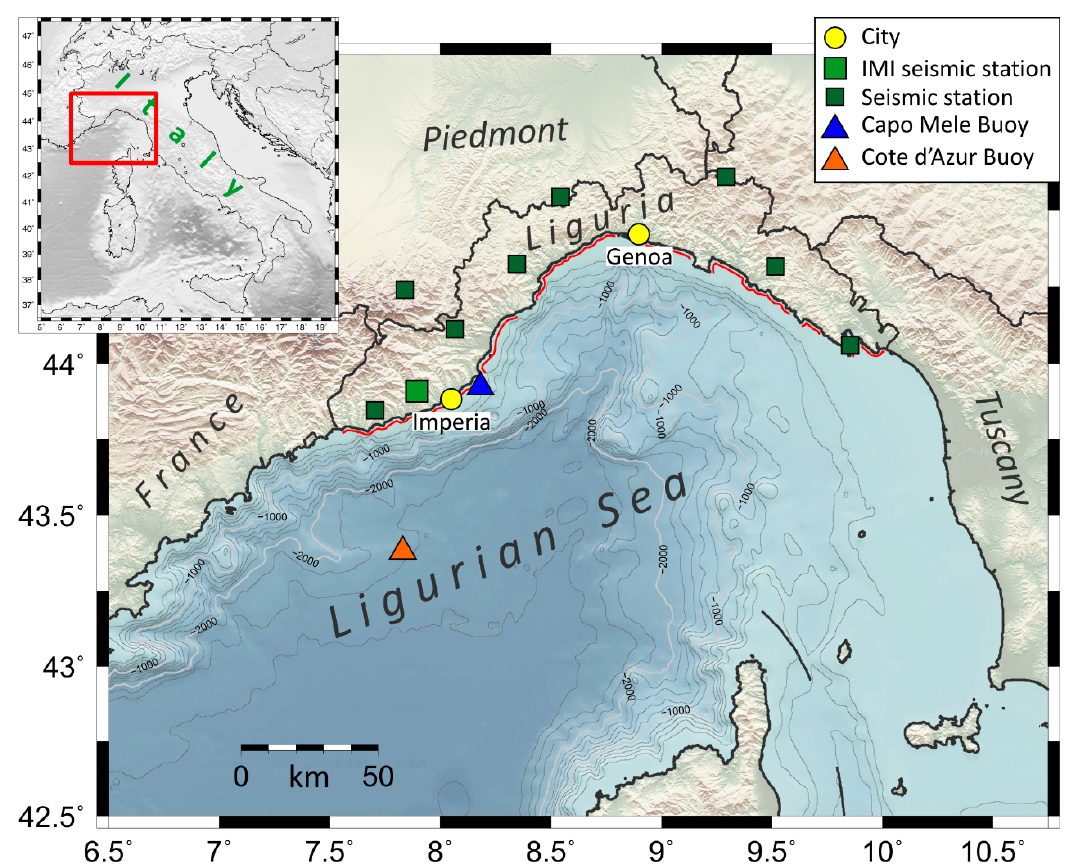
Figure 1. Location of the Imperia seismic station (IMI; large green square), the other Regional Seismic network of north- western Italy (RSNI) seismic stations located near the Ligurian coast (small green squares) and the two buoys (Capo Mele—Italy and Cote d’Azur—France; blue and orange triangles, respectively) considered in this study. The tide gauge station of Imperia Porto Maurizio and the weather station of the Seismic and Meteorological Observatory of Imperia are located in the city of Imperia. Red line shows the coastal area affected by damages.